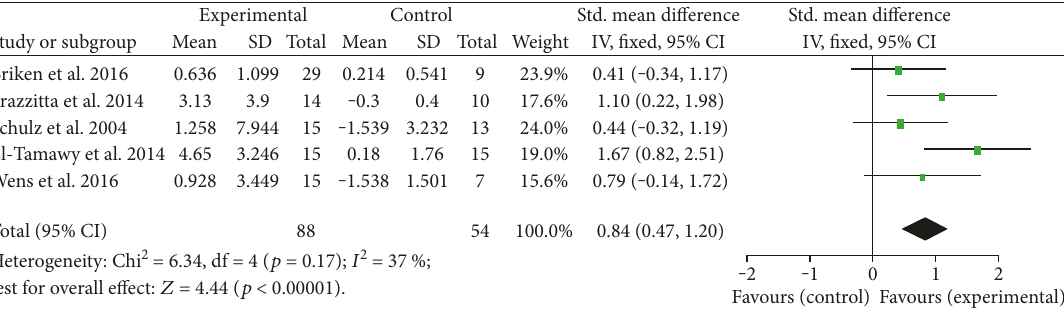
Figure 3: Meta-analysis of RCT/CT studies investigating a program of aerobic exercise (experimental group) versus usual care/nil therapy (control